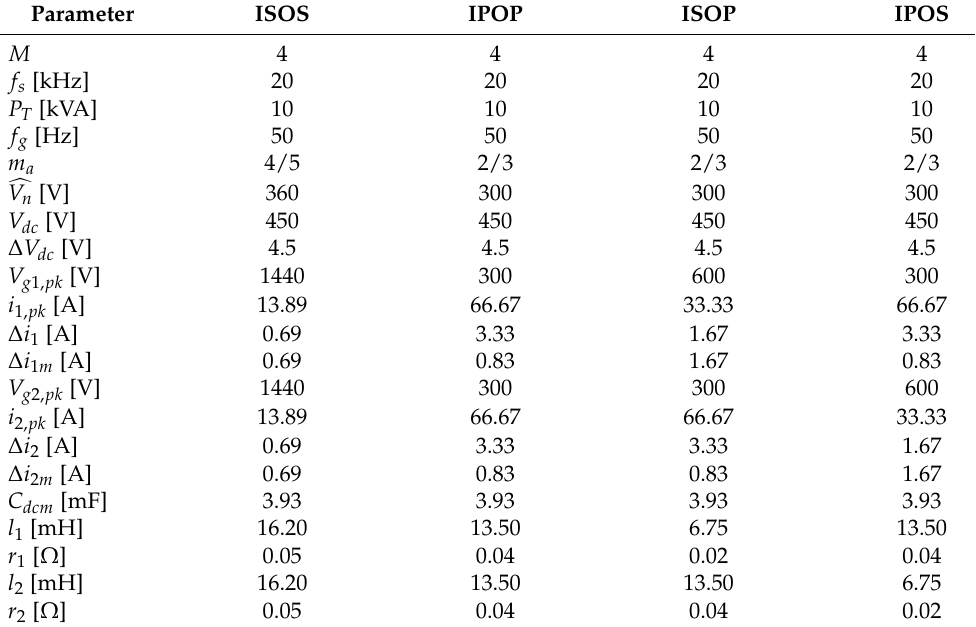
Table 5. Sizing for the different configurations of the 4-modules CHB-B2B converter.